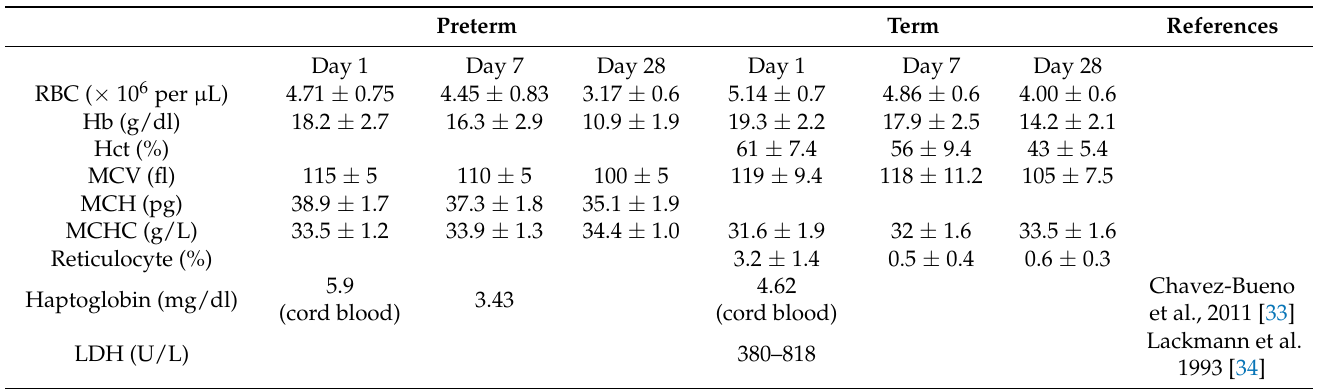
Table 2. Reference ranges of the main hematologic parameters in term and preterm neonates.